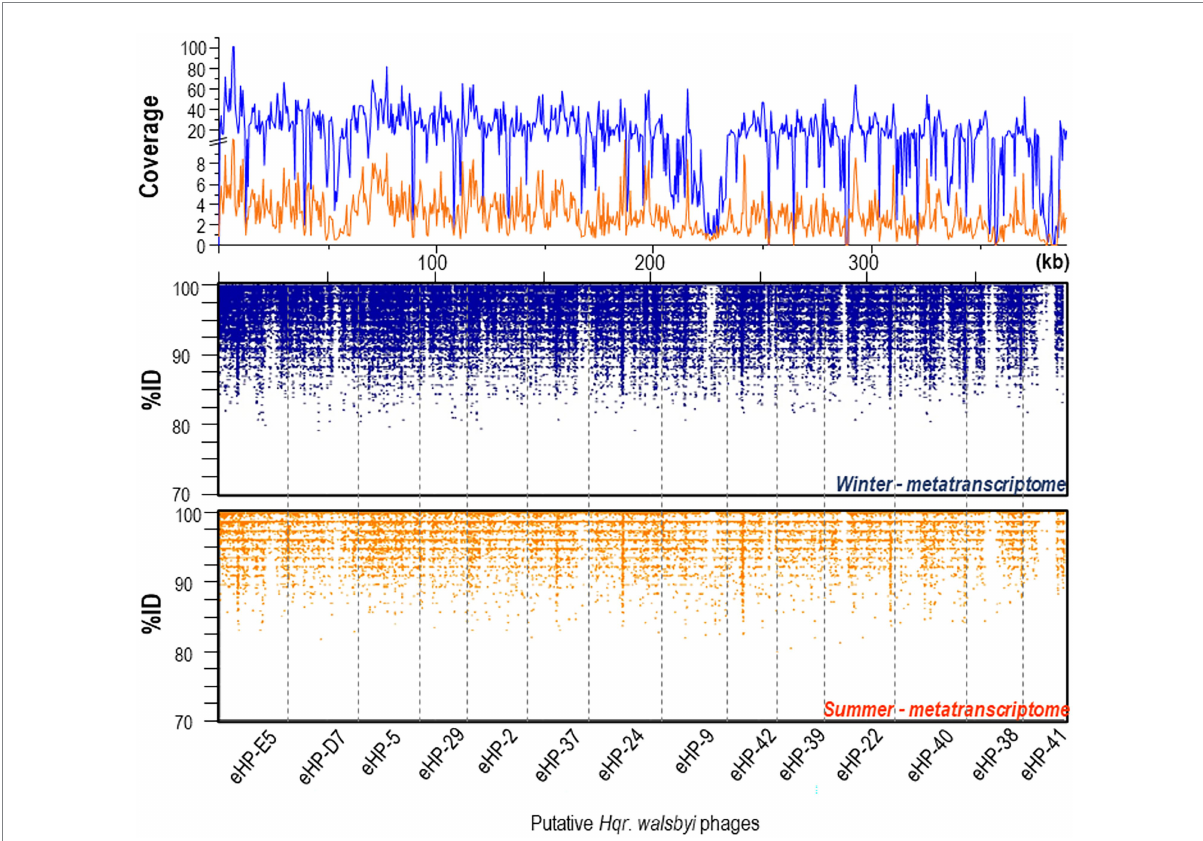
FIGURE 3 Recruitment plots of putative Hqr. walsbyi virus genomes (eHP-) against metatranscriptomic reads from summer (bottom panel) and winter (middle panel) samples. (Top panel) Coverage plot of the metatranscriptomic reads mapped onto the viral genes in summer (orange) and winter